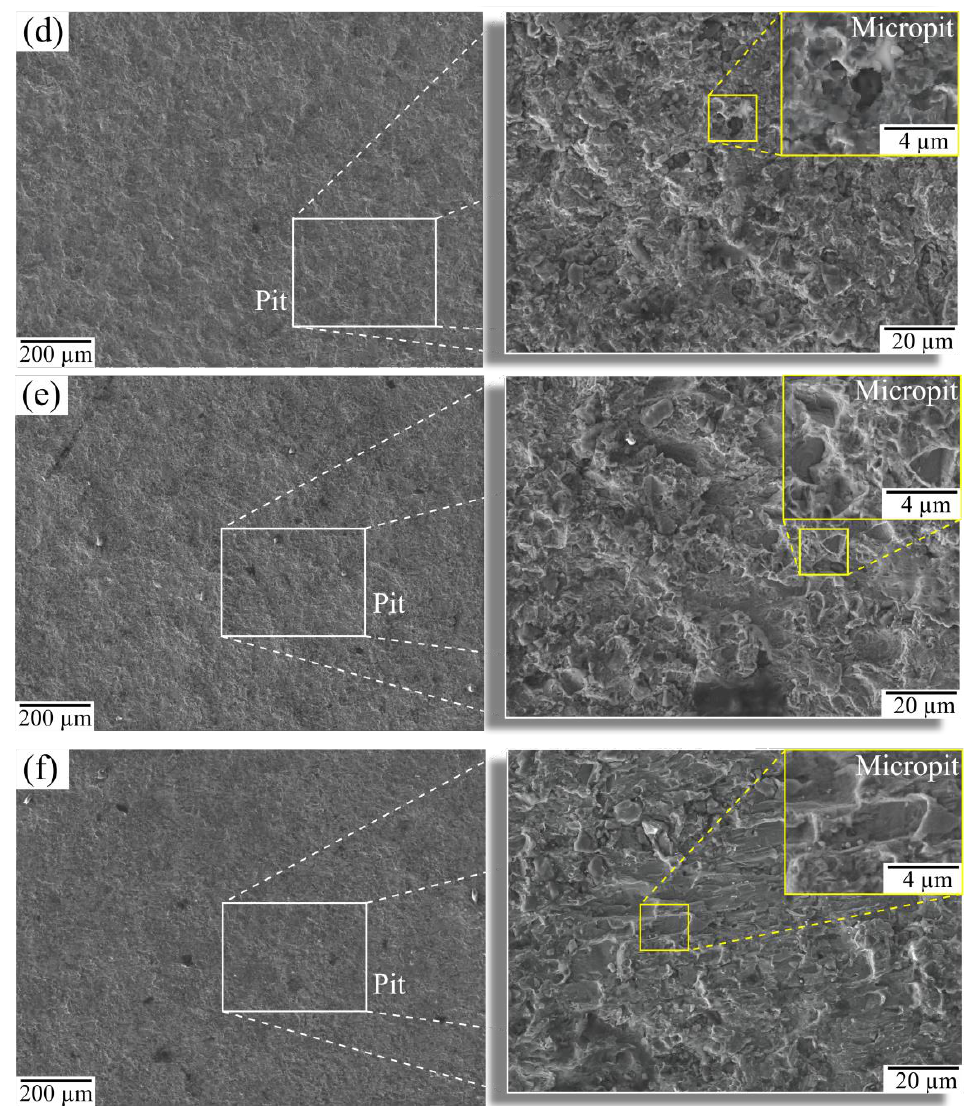
Figure 2. SEM micrograph of surface microstructure of samples. ( a ) control group T0; ( b ) group T1; ( c ) group T2; ( d ) group T3; ( e ) group T4; ( f ) group T5.